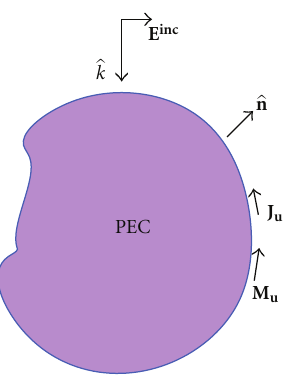
Figure 1: The 3D electromagnetic scattering problem of conduct- ing object coated by thin